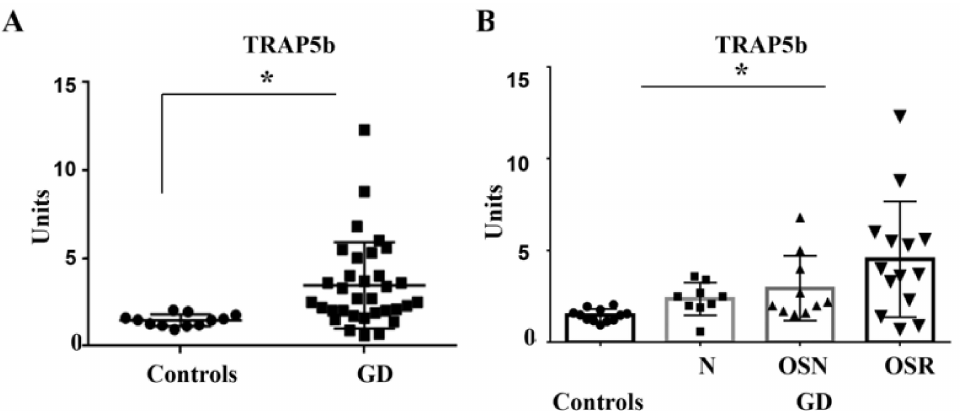
Figure 1. Plasma TRAP5b level. ( A ) TRAP5b level, GD (Gaucher disease) mean 3.4 ± 0.4, n = 33 vs. control mean 1.4 ± 0.1, n = 10, p < 0.05 unpaired t -test and F test. ( B ) TRAP5b concentrations in control and GD cohorts. GD and no bone complication (N, mean 2.6 ± 0.63), osteopenia (OSN, mean 3.1 ± 1.8), and osteoporosis (OSR, mean 4.2 ± 2.2). * p < 0.05; ANOVA, Brown-Forsythe,